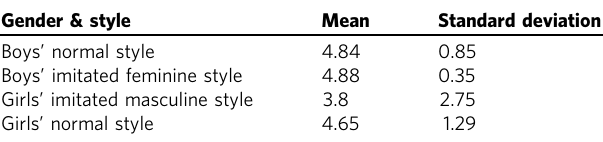
Table 15 Descriptive statistics of sentiment scores across the four speaking